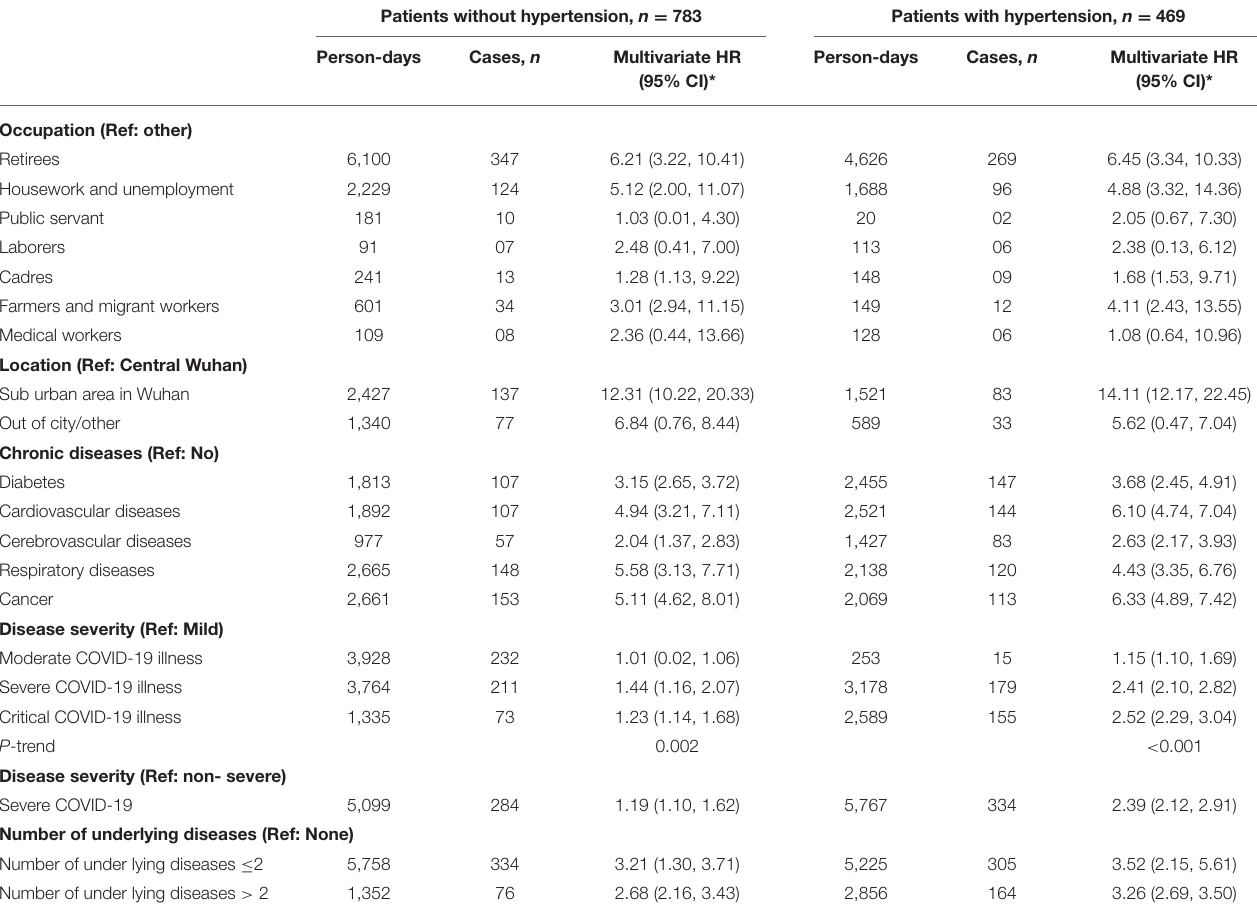
TABLE 5 | Multivariable Cox regression analysis for factors associated with the mortality in 1,252 COVID-19 patients stratified by the hypertension status after the propensity score-matching for age and sex. Patients without hypertension, n =